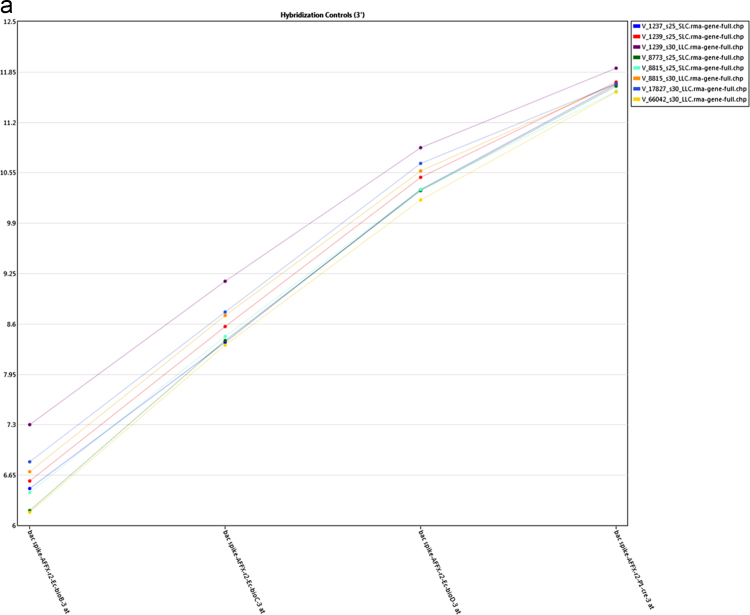
a: Signal data from 3′ hybridization controls from all samples. b: Signal data from 5′ hybridization controls from all samples. c: Signal box plots of array files before (CEL) and after (CHP) normalization.